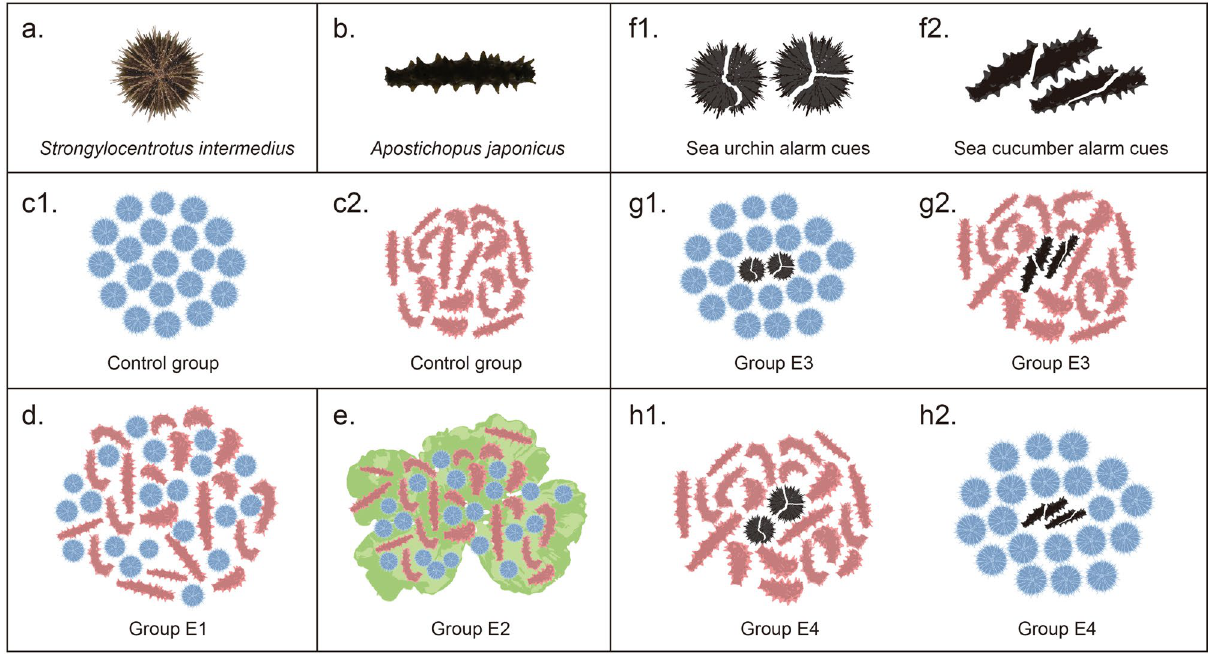
Figure 1. Schematic diagrams for the experiments. ( a ) Strongylocentrotus intermedius and ( b ) Apostichopus japonicus . In experiment 1, either 20 sea urchins or 20 sea cucumbers in different tanks were recorded